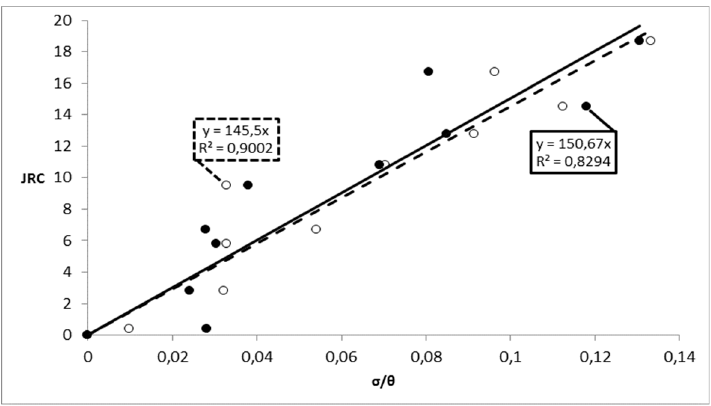
Figure 5. Graph comparing the JRC- σ / θ relationship extracted from Barton and Choubey’s [4] and Tse and Cruden’s [3] image (white and black dots respecrively).